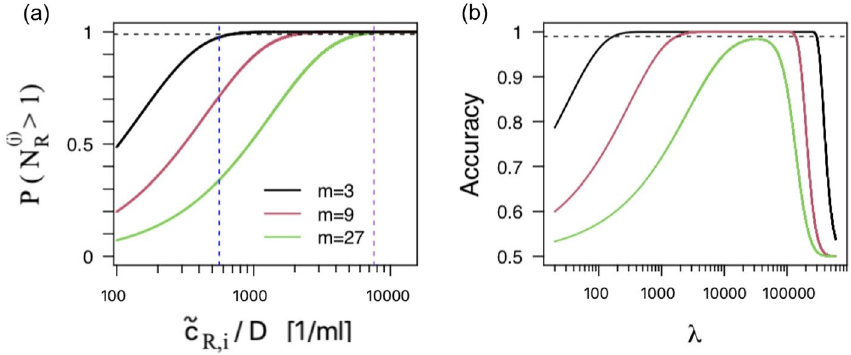
Figure 6. ddPCR and RNA quantification. ( a ) Probability of having at least one RNA molecule in the testing 3 , red: m 9 , green: m 27 ) in which only one sample corresponds to an volume of an m j pool (black: m j j = j = = c R infected individual whose viral genome concentration is i . The blue vertical line corresponds to the minimal ˜ ; viral RNA amount (quantified with ddPCR) detected in individual samples of people infected with SARS-CoV-2 and the one in purple to the average minus SEM (651-501 copies/test) detected in nasal swabs 35 ). The dashed 0.99 . ( b ) Accuracy of the test that discriminates between horizontal line corresponds to the probability P = having one flawed sample in an m -sample pool and having none, as a function of the expected number of RNA molecules, (cid:31) , in a volume of size, V s , of the original sample, when a ddPCR is run on the pool subdividing the 3 (black), m 9 20, 000 sub-volumes. The pool sizes illustrated are m DV s , into M testing volume, V t = = = = 27 (green). Here (cid:31) is the expected number over the whole human population. The dotted line (red) or m = corresponds to the accuracy,